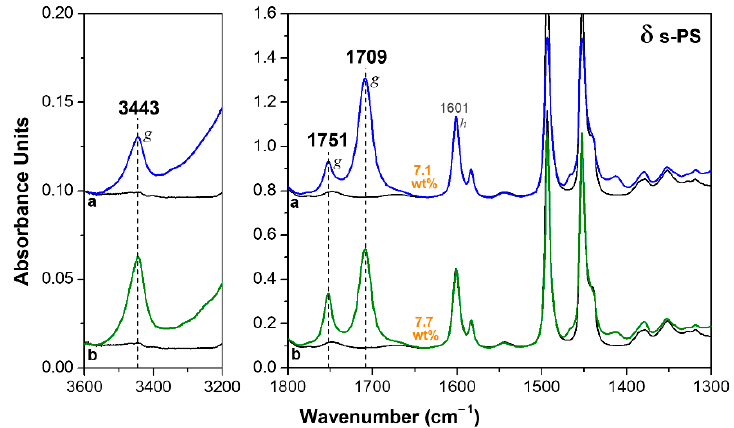
Figure 3. FTIR spectra of an axially oriented δ form s-PS film, after immersion in: ( a ) HA at 70 °C for 12 h; ( b ) 40 wt% solution of HA in acetone at room temperature for 12 h, followed by acetone desorption at 80 °C for 1 h. The uptake of HA in the film (expressed as wt%) is indicated close to the spectra.